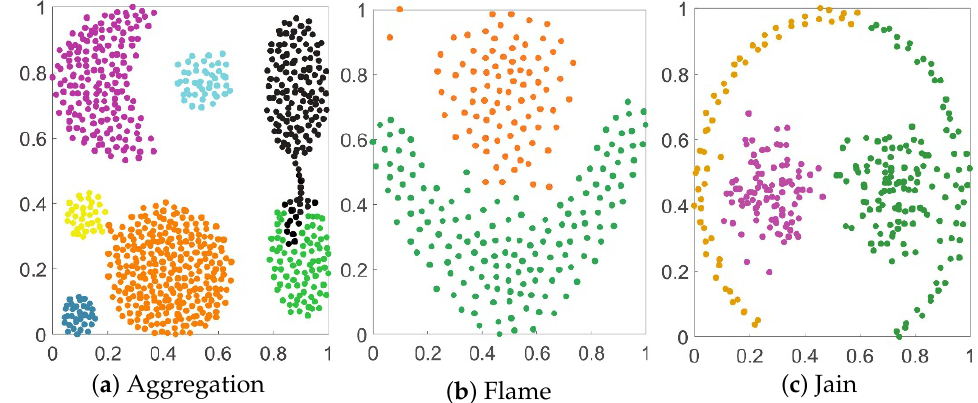
Figure 3. Clustering effect of the DBSCAN algorithm on Aggregation, Flame, and Jain.